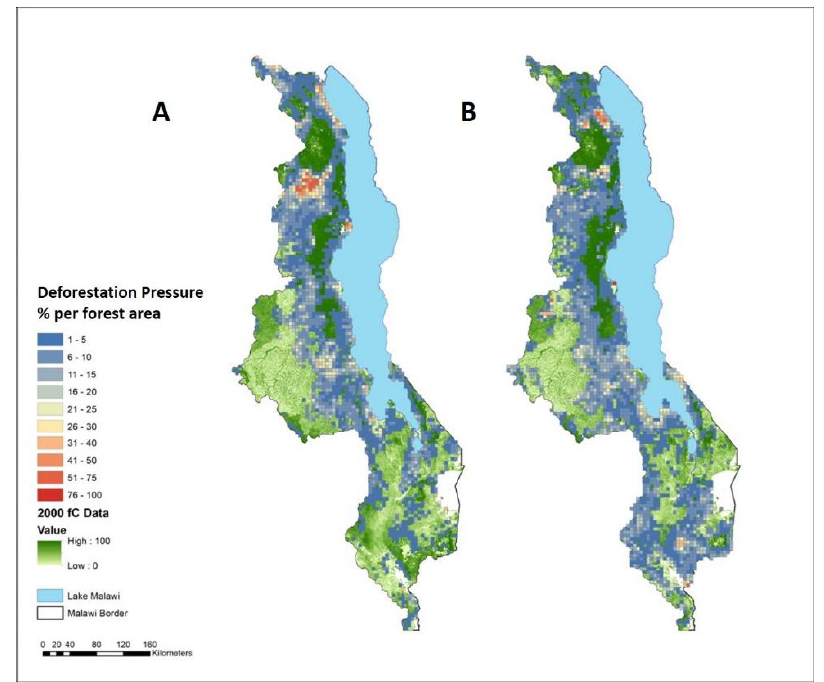
Figure 9. Mapping of the pressure on remaining forest resources from deforestation, 2000–2009 ( A ), 2010–2015 ( B ). The total area deforested at each date is expressed as a percent fraction of the forest area in each 25 km 2 grid cell.